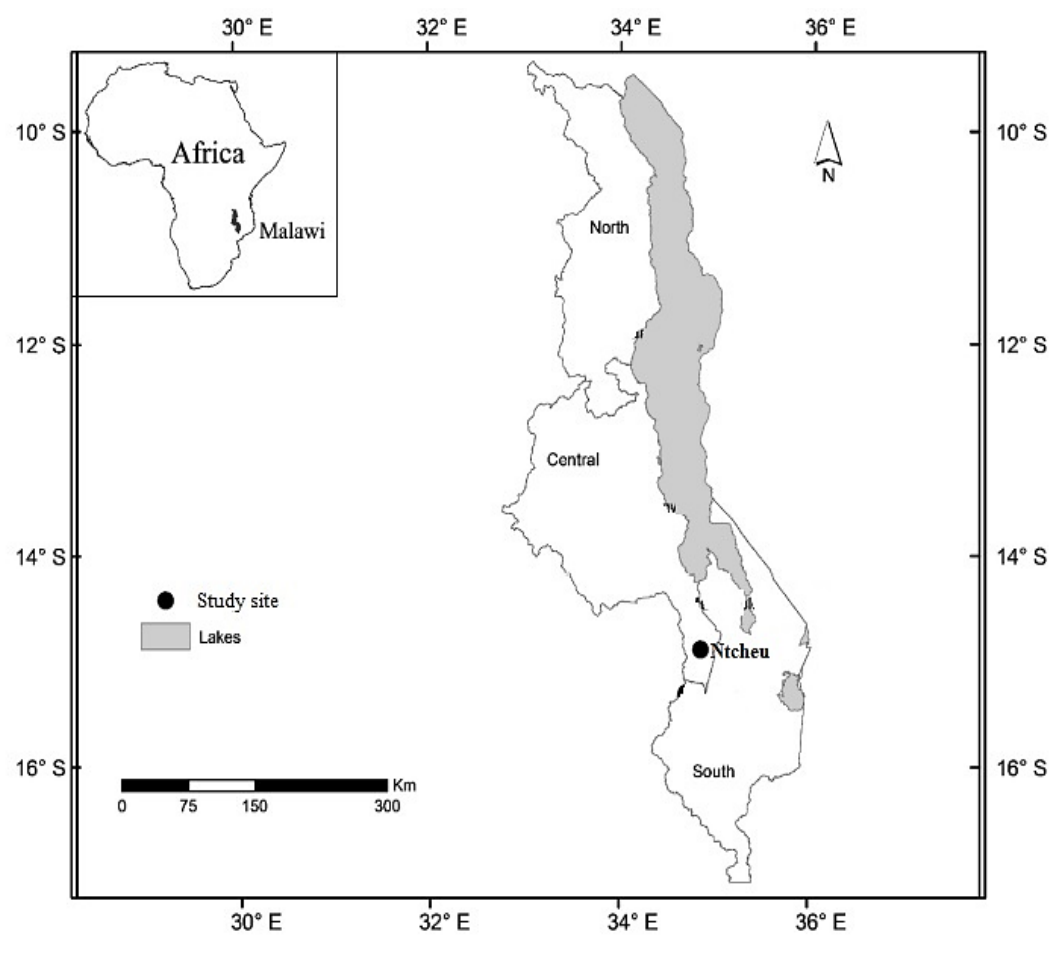
Figure 1. Map of Malawi showing the location of the study